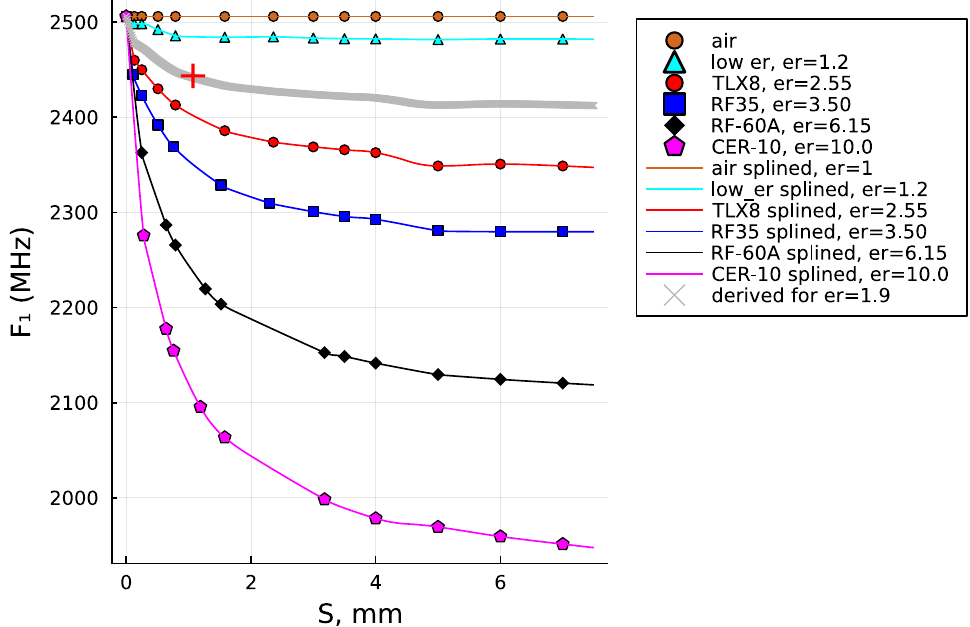
Figure 10. An example of how an additional reference curve was inserted to eventually improve the accuracy of the solution in a segment. A “lower” curve with (cid:101) r = 1.2 (in cyan color) is inserted between the “air” curve and the “TLX8” curve. The outcome is that the computed value of the jeans SUT (here indicated by the red plus sign on the grey curve) is now 1.9, which is closer to the nominal value than before when it was equal to